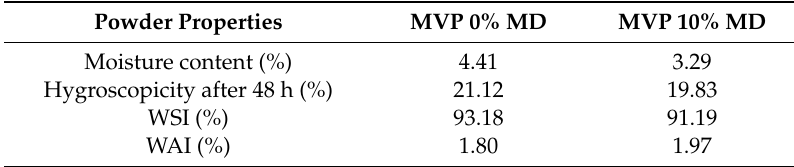
Table 4. Characterization of MVPs obtained from subcritical liquid